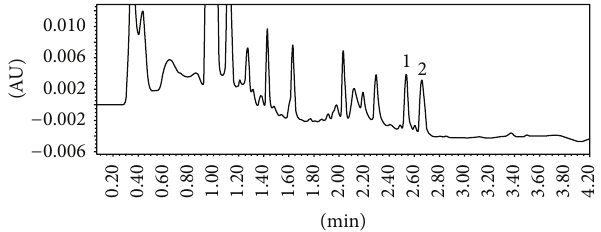
Figure 3: Typical chromatogram of human plasma sample spiked with (1) ibrutinib at 200 ng/mL (RT: 2.54 min) and (2) diclofenac at 250 ng/mL (RT: 2.66